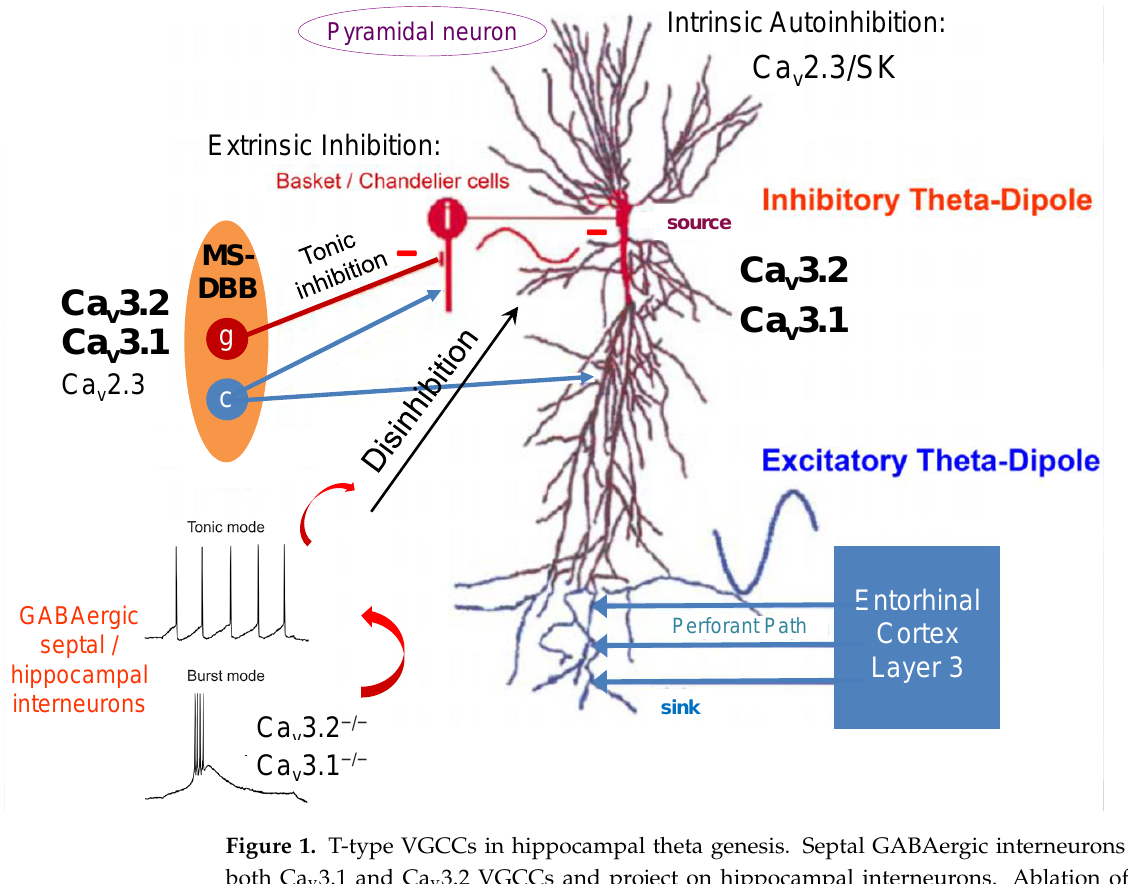
Figure 1 (Papazoglou et al., 2022)